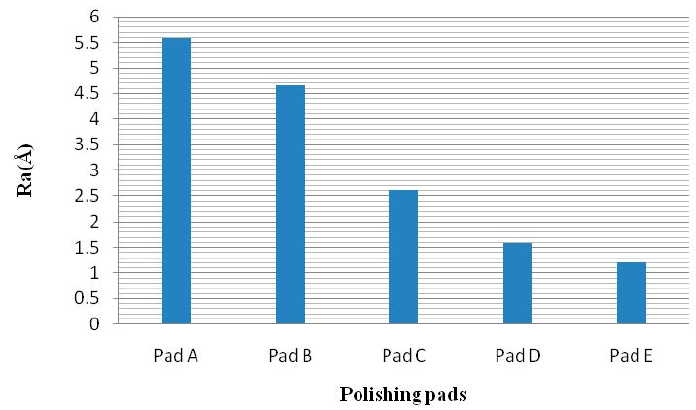
Figure 6. Comparison of the surface roughness (Ra) of SiC wafer after polishing with different polishing pads.